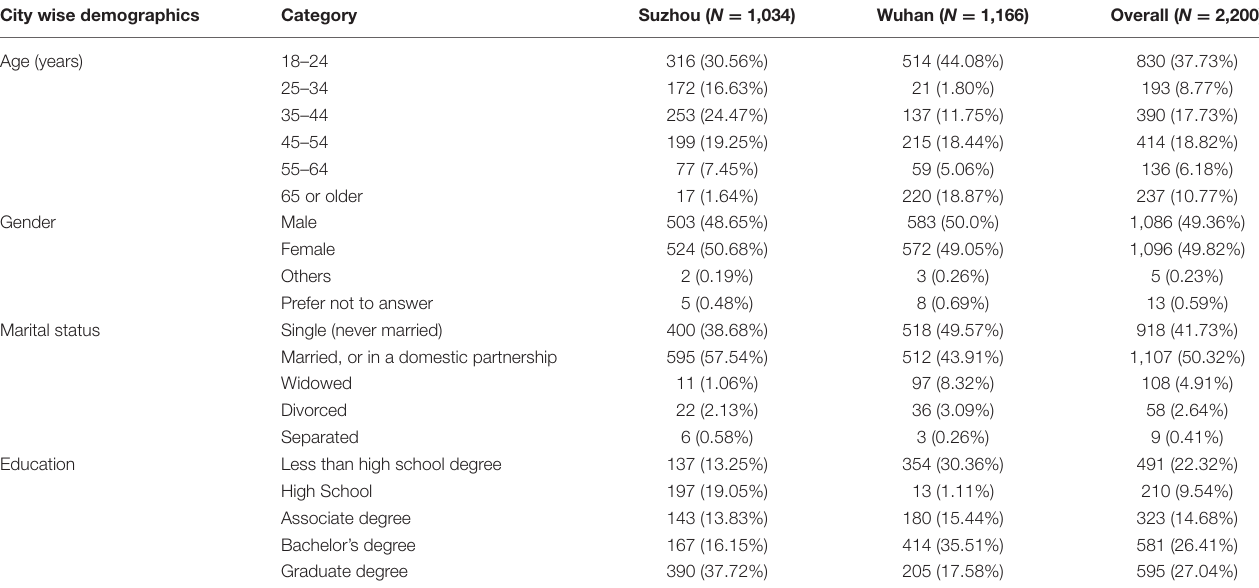
TABLE 1 | Demographic characteristics of the survey participants. City wise